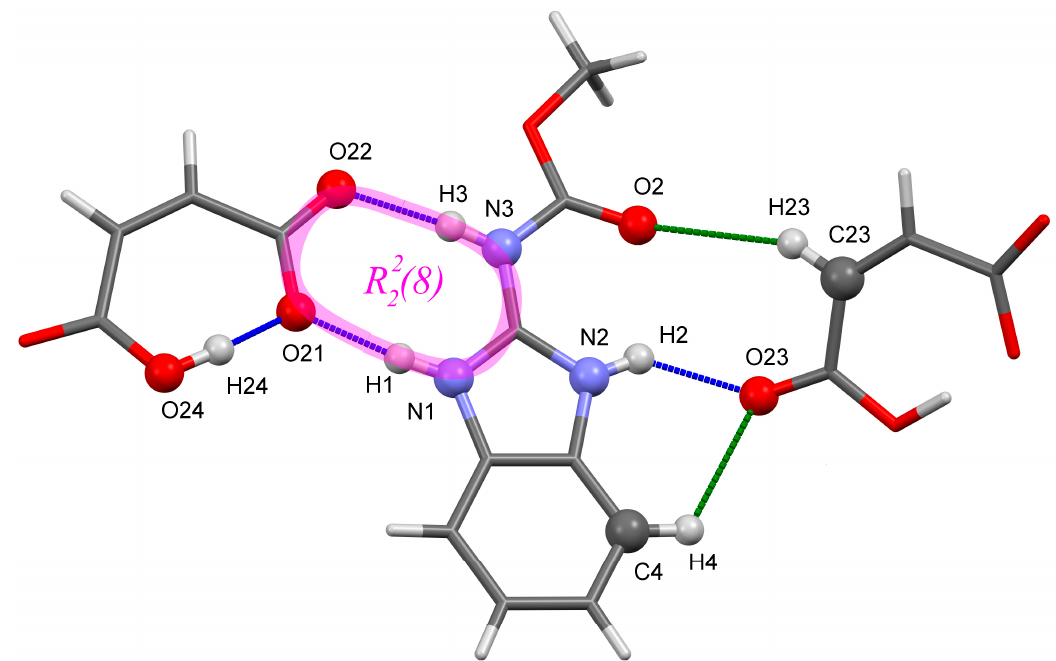
Figure 2. Part of the hydrogen bond network in [CRB + MLE] (1:1). The H-bonds and C–H ··· O contacts are colored blue and green, respectively.